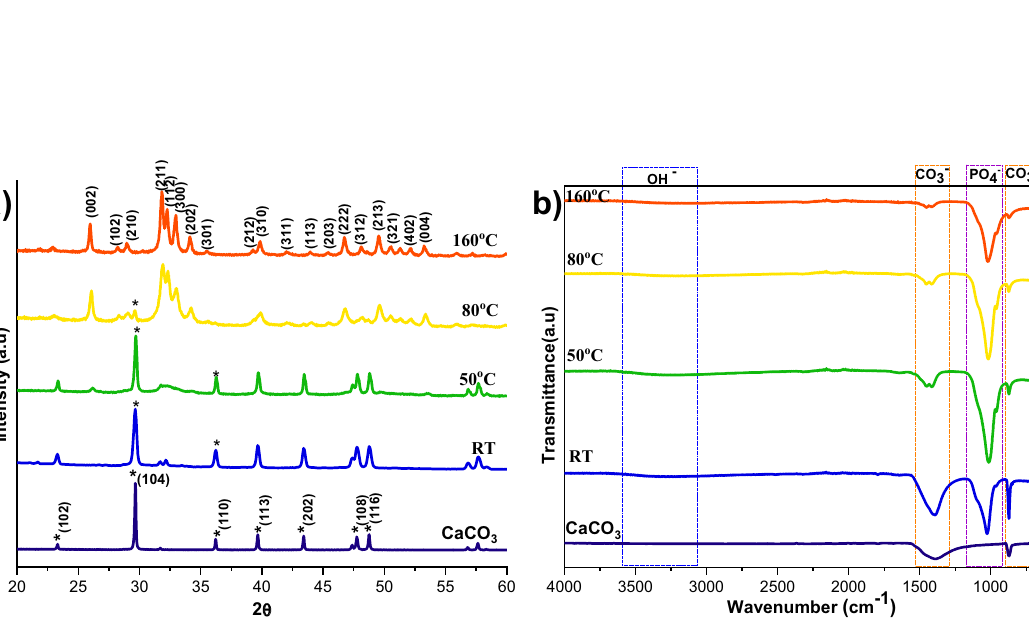
Figure 6. XRD ( a ) and FTIR ( b ) spectra of HAp prepared at a different reaction